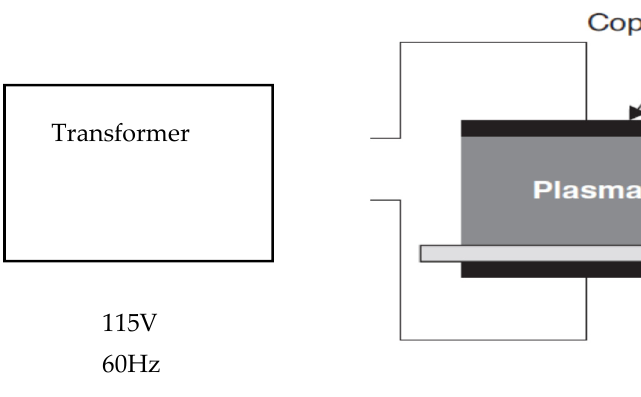
Figure 5. Dielectric barrier discharge [28].